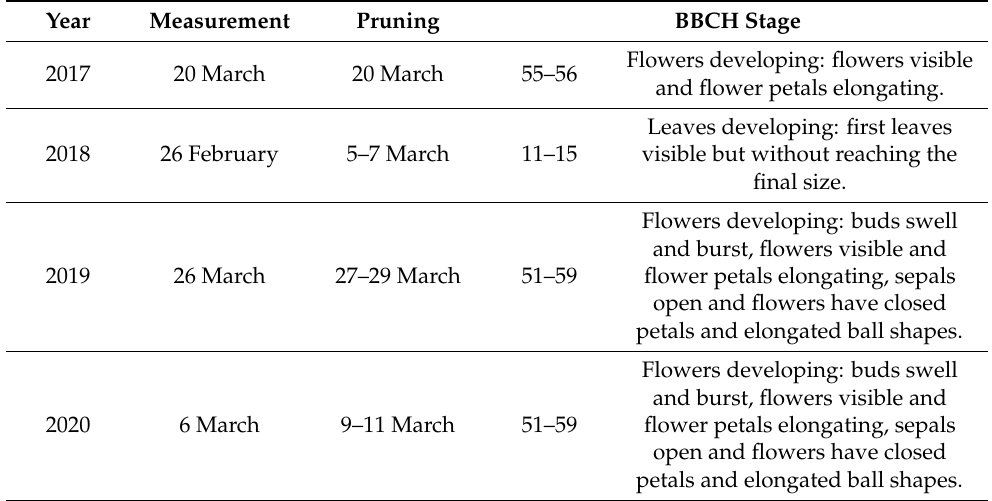
Table 2. Dates of the canopy dimension measurements, and dates of the pruning and BBCH citrus developmental stage at pruning times [37].